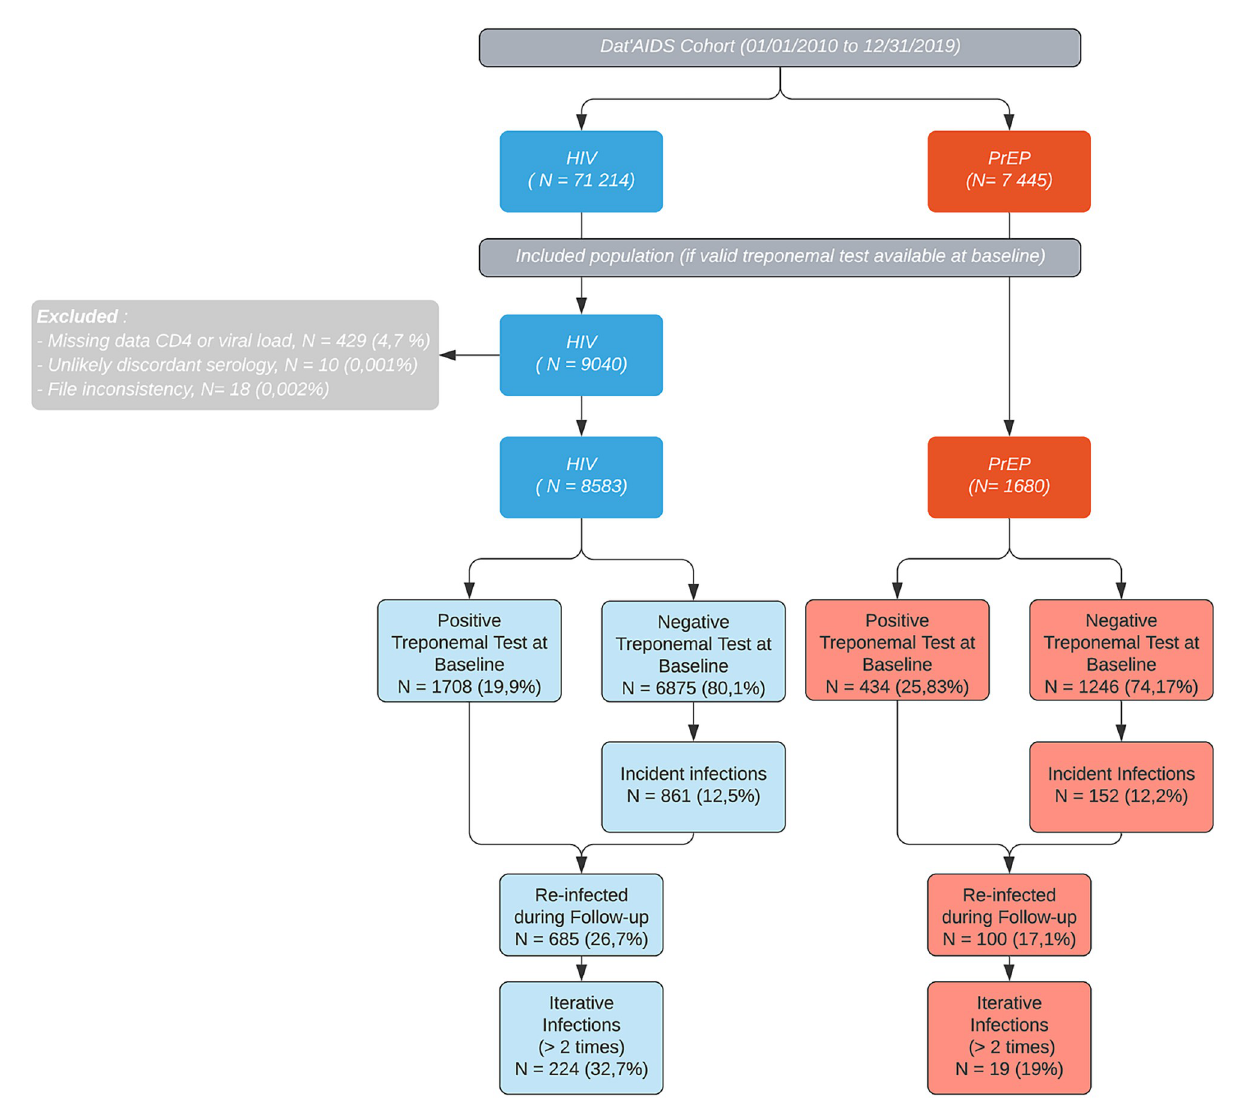
Fig 1. Flowchart. PLWH with syphilis were mostly male (92.4% vs. 69.2%, p < 0.001) and MSM (77.6% vs.44%, p < 0.001). There was no significant difference in syphilis infection rate according to HIV viral load at baseline. In multivariable model, female had a lower risk of being infected by syphilis at baseline than male (OR (95% CI) = 0.31(0.24; 0.39)). Transgenders had a higher risk compared to male (OR (95% CI) = 1.81 (1.14; 2.86)). Moreover, the risk of syphilis increased with age (higher risk in 35–47 years old subjects and 47–88 years old subjects compared to 15–35 ones (OR (95% CI) respectively at 1.34 (1.16; 1.54) and 1,37 (1.18; 1.58)), was higher in MSM compared to heterosexual subjects and those with other HIV risk factors (OR (CI 95%) = 3,05 (2.60; 3.58) and 1.44 (1.10; 1.86) respectively), and lower in CDC Stage C subjects (OR (95% CI) = 0.80 (0.66; 0.96)).